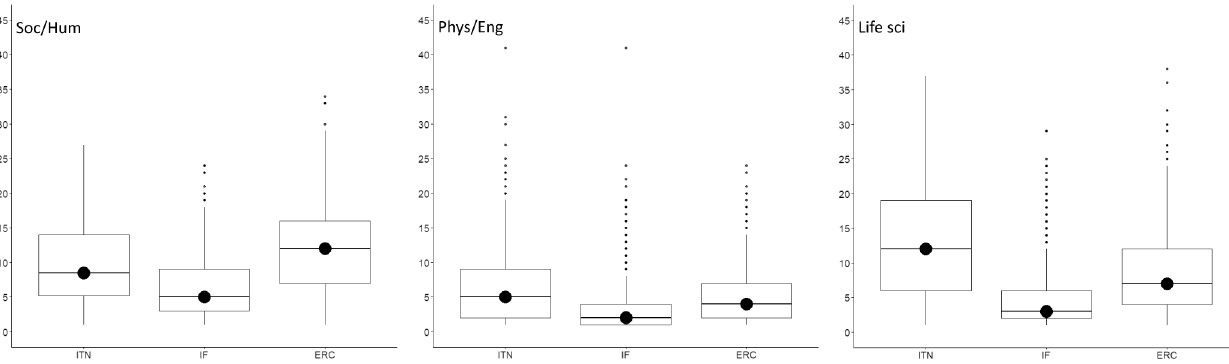
Figure 9. Median number of ethics requirements identified by ethics experts, by research domain. ITN – Innovative Training Networks, IF – Individual Fellowships, ERC – European Research Council grants. The data are from years available in the SEP tool of the European Commission. Soc/Hum – Social Sciences and Humanities, Phys/Eng – Physical Sciences and Engineering, Life sci – Life